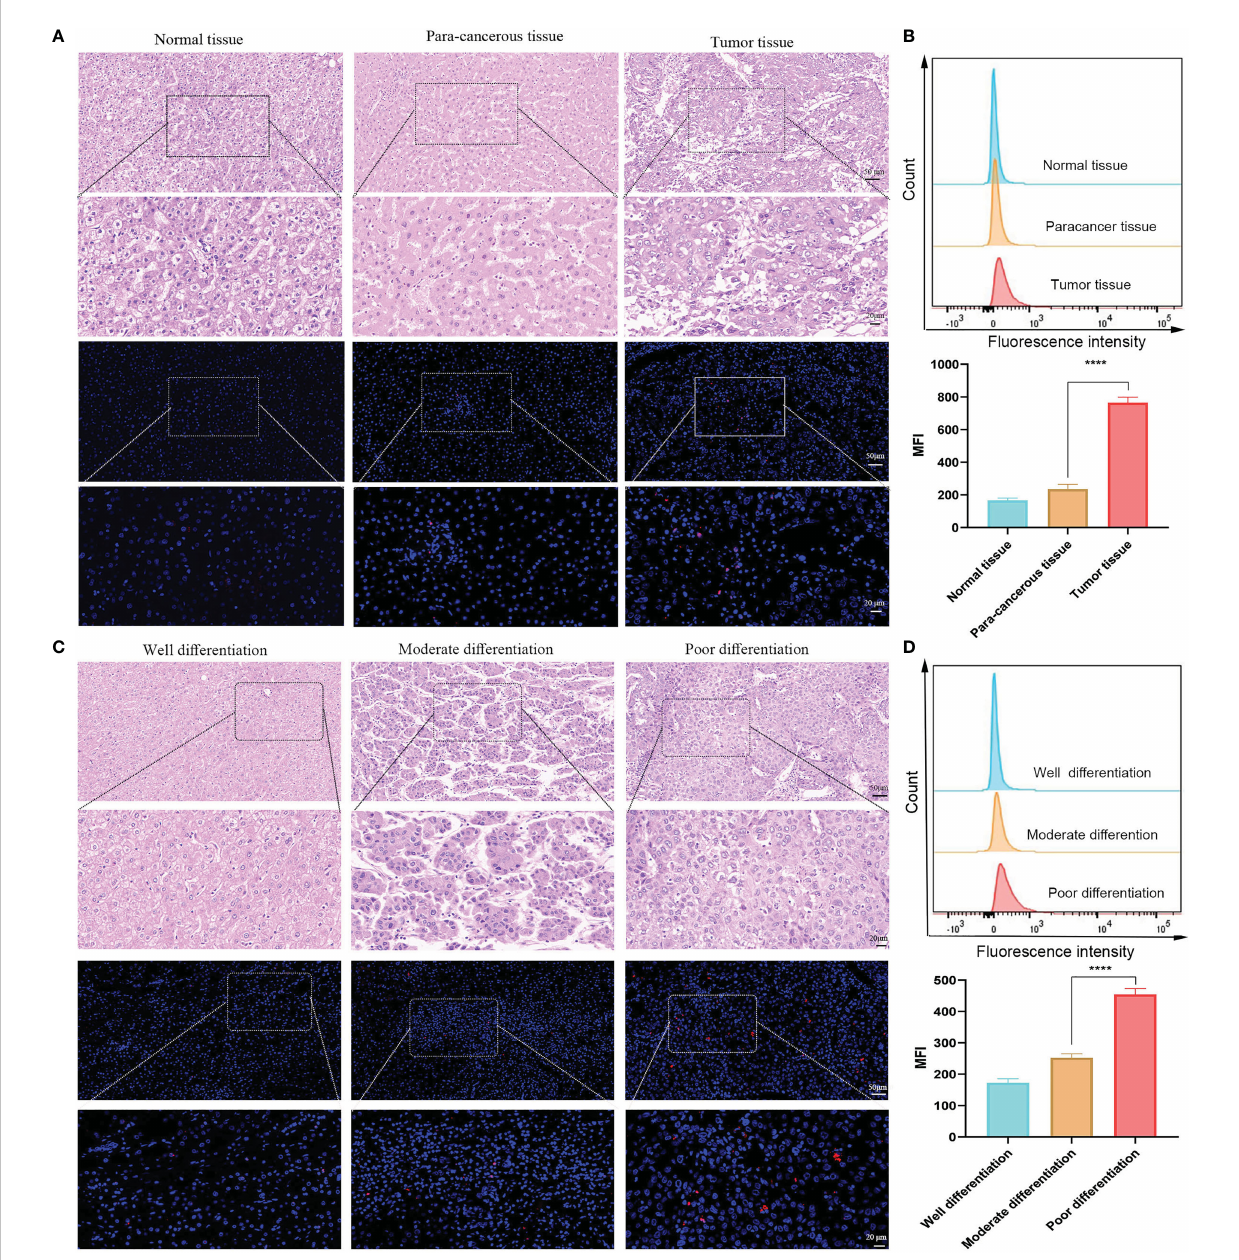
FIGURE 2 TIGIT expression in human HCC. (A) Representative IF staining of TIGIT in different parts of tissue. (B) Flow cytometric analysis of TIGIT expression on lymphocytes in different parts of tissue (n=3). (C) Representative IF staining of TIGIT in various differentiated tumor tissue. (D) Flow cytometric analysis of TIGIT expression on lymphocytes in different differentiated tumor tissue (n=3). (Scale bar: Up, 50 m m; Down, 20 m m). **** P <